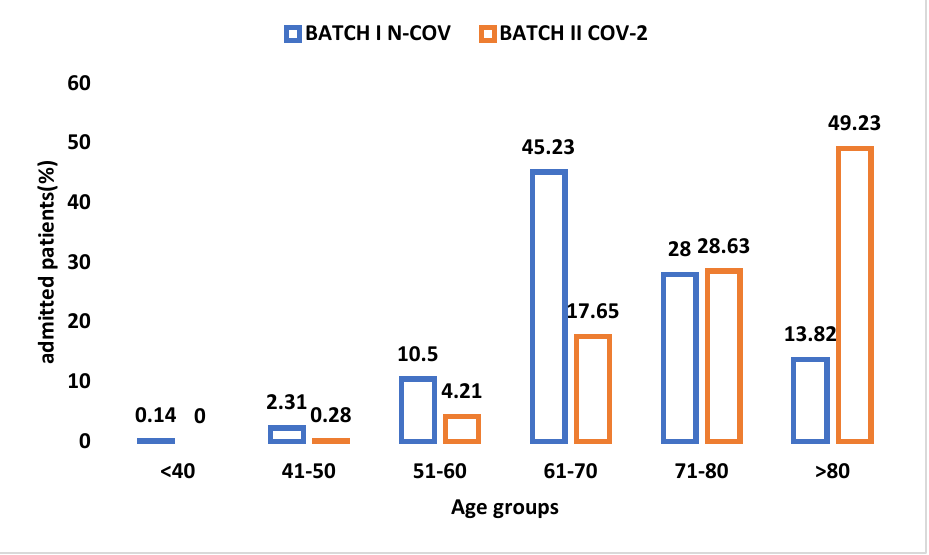
Figure 9 . The distribution of patients by age group in both the studied groups .